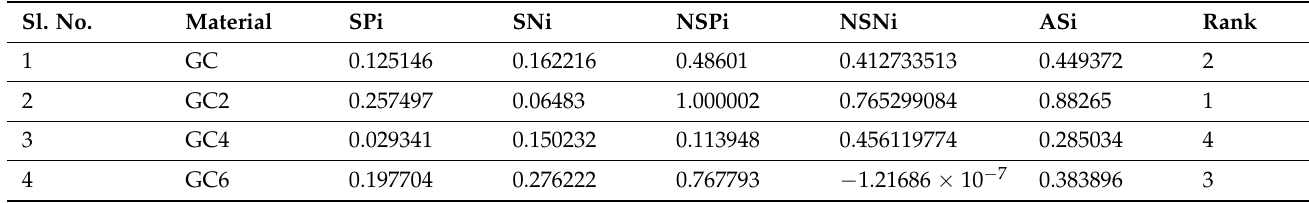
Table 9. Ranking by using